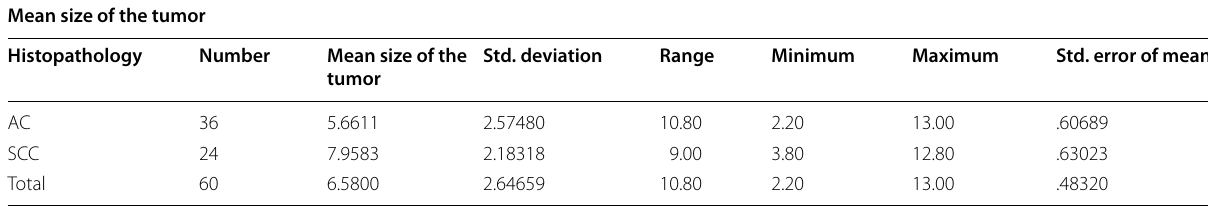
Table 2 Shows the mean size of the tumor including the standard deviation, and range based on the histopathological